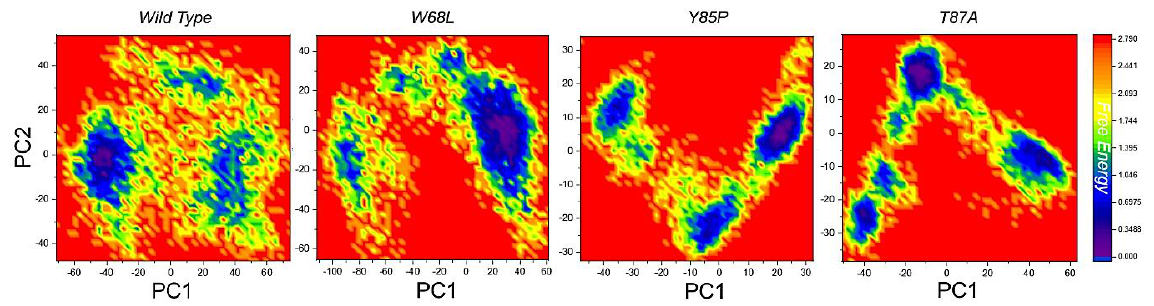
The first PC1 and second PC2 from the PCA of the backbone carbon were used.